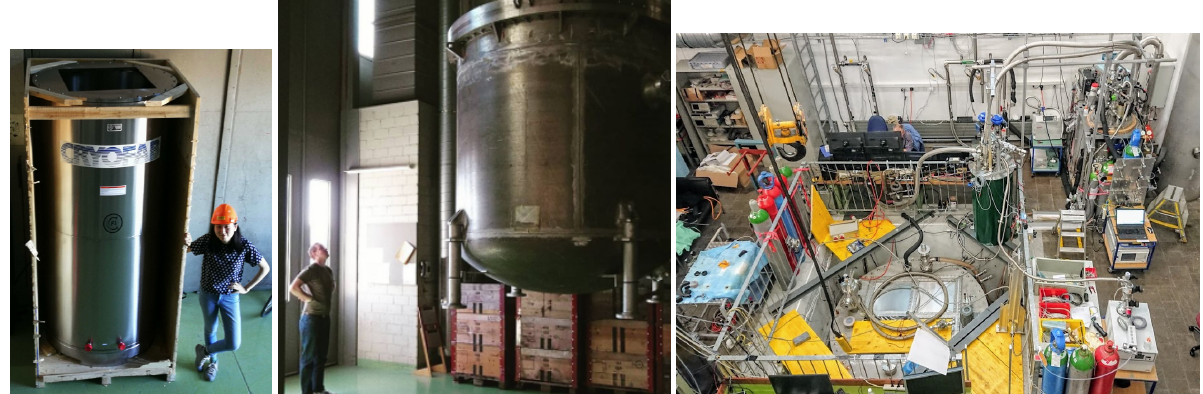
Figure 17. ( Left ) The cryostat for testing Module 0. ( Center ) The cryostat for the ArgonCube 2 The 2 2 cryostat and cryogenics system at the Univ. of ×